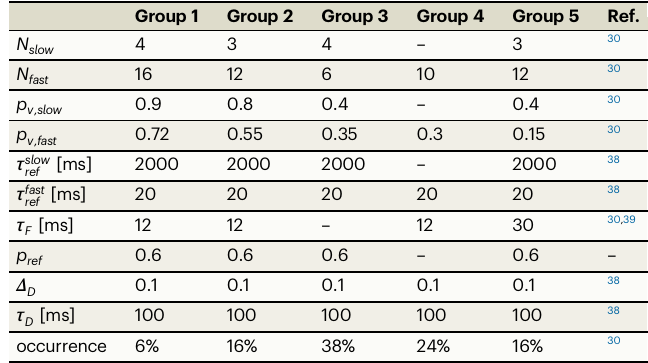
Table 1 | Synaptic parameters used in full model